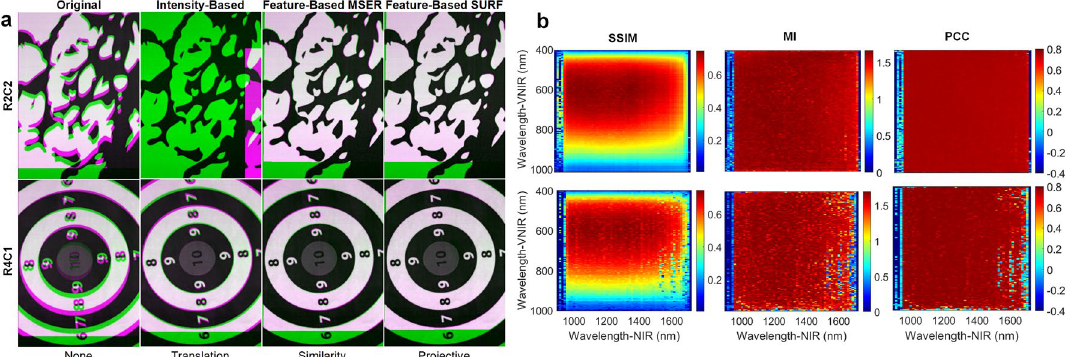
Figure 1. VNIR–NIR Spatial Registration using the HSI registration dataset . ( a ) Two registration result examples applying different registration techniques. Both images are overlapped using green-magenta false- color, VNIR (green) and NIR (magenta). First column shows the default registration without applying any type of transformation to the data. Second, third and fourth columns show the results of the intensity-based, feature- based with MSER, and feature-based with SURF techniques, respectively, using the best transformation method. ( b ) Coarse search results of the Structural Similarity Index Measure (SSIM), the Mutual Information (MI), and the Pearson’s Correlation Coefficient (PCC) for identifying the suitable spectral bands for the registration using the feature-based SURF technique with projective